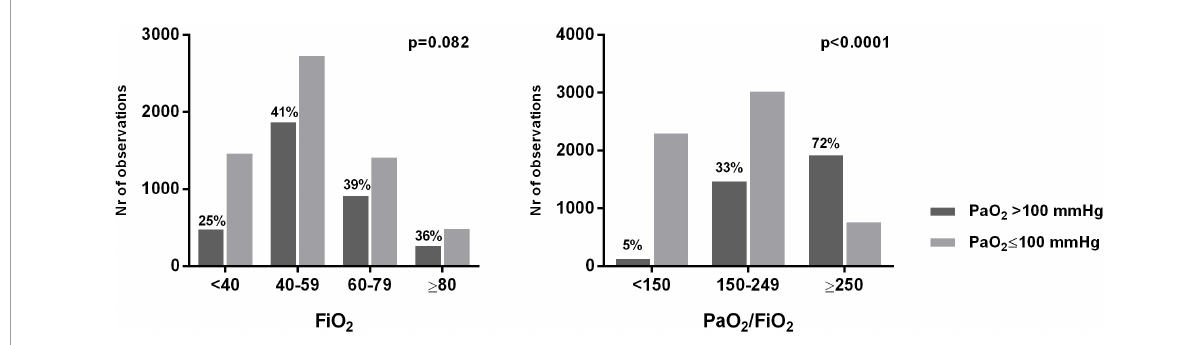
FIGURE1 Number and percentage of arterial blood gases showing hyperoxemia stratified by PaO 2 and FiO 2 levels.